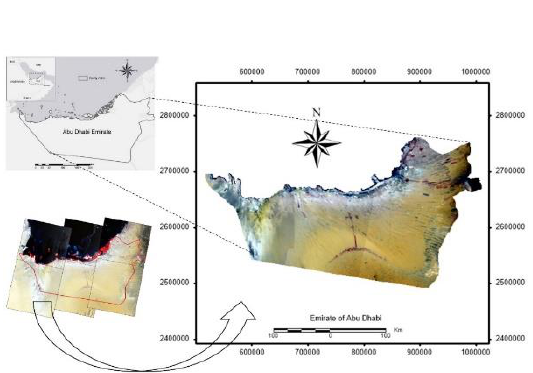
Figure 2. Study area (six Landsat-8 OLI images used to create one single mosaic